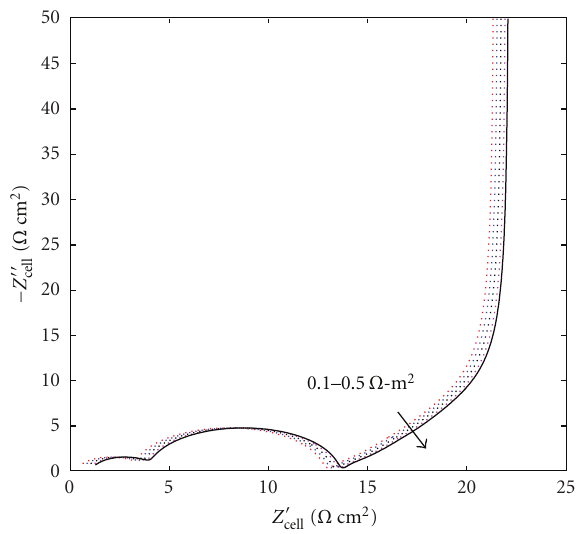
Figure 3: E ff ect of contact resistance on the impedance response of the cathode: the incorporation of an ohmic drop across the ter- minals shifts the real axis of the nominal response to more positive